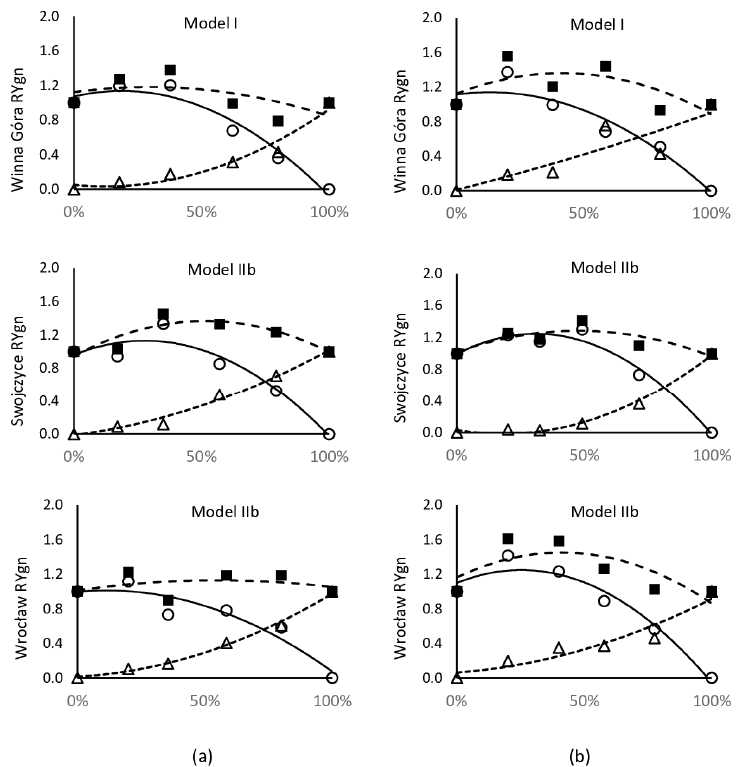
Figure 3. The replacement competition model for the relative seed number (RYse) of winter wheat and cornflower (B) in the 2017–2018 season (classified according to the t -test and p < 0.05). ( a ) competition between WW and B resistant (R) and ( b )competition between WW and herbicide-susceptible cornflower (S). Legend: o—WW; ∆ —R ( a ) or S ( b ), □ —WW + R ( a ) or WW + S ( b ). The competitive ratio (CR) in the plant ratios of 6WW:4B and 4WW:6B was measured for two parameters, i.e., biomass and seed number of WW and B. The ANOVA indicated that site and site × biotype interaction were statistically significant for both CRs. Additionally, biotype was significant for biomass (Table